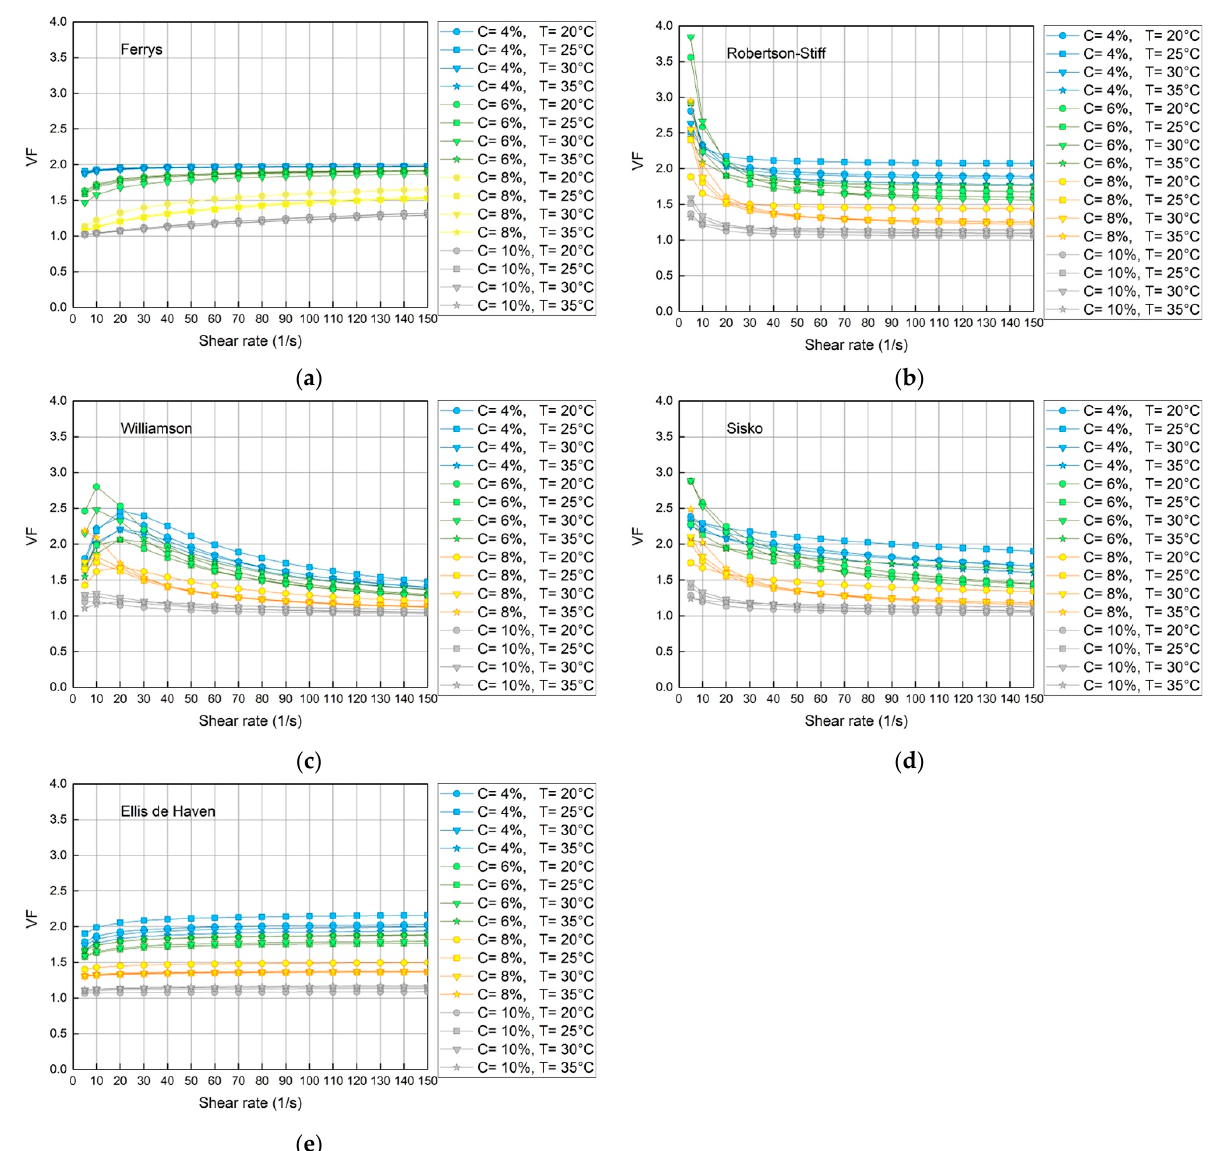
Figure 2. Relationship between apparent viscosity and di ff erences according to evaluated models. The behavior between the apparent and di ff erential viscosity according to the model of ( a ) Ferrys, ( b ) Robertson-Sti ff , ( c ) Williamson, ( d ) Sisko, and ( e ) Ellis de Haven. The ANOVA results for the di ff erent models at the level of the parameters 𝑅 (cid:2870) and 𝑆 (cid:2870) , Table 4. Analysis of variance for the coefficient of determination ( R 2 ) and variance ( S 2 ) according to it can be seen that they are signi fi cantly di ff erent from each other, showing a signi fi cant value at the critical alpha of 0.05 and at 0.01 (see Table 4). Therefore, they are consistent in appropriately modeling the prediction of the rheological properties of vinyl alcohol solutions.